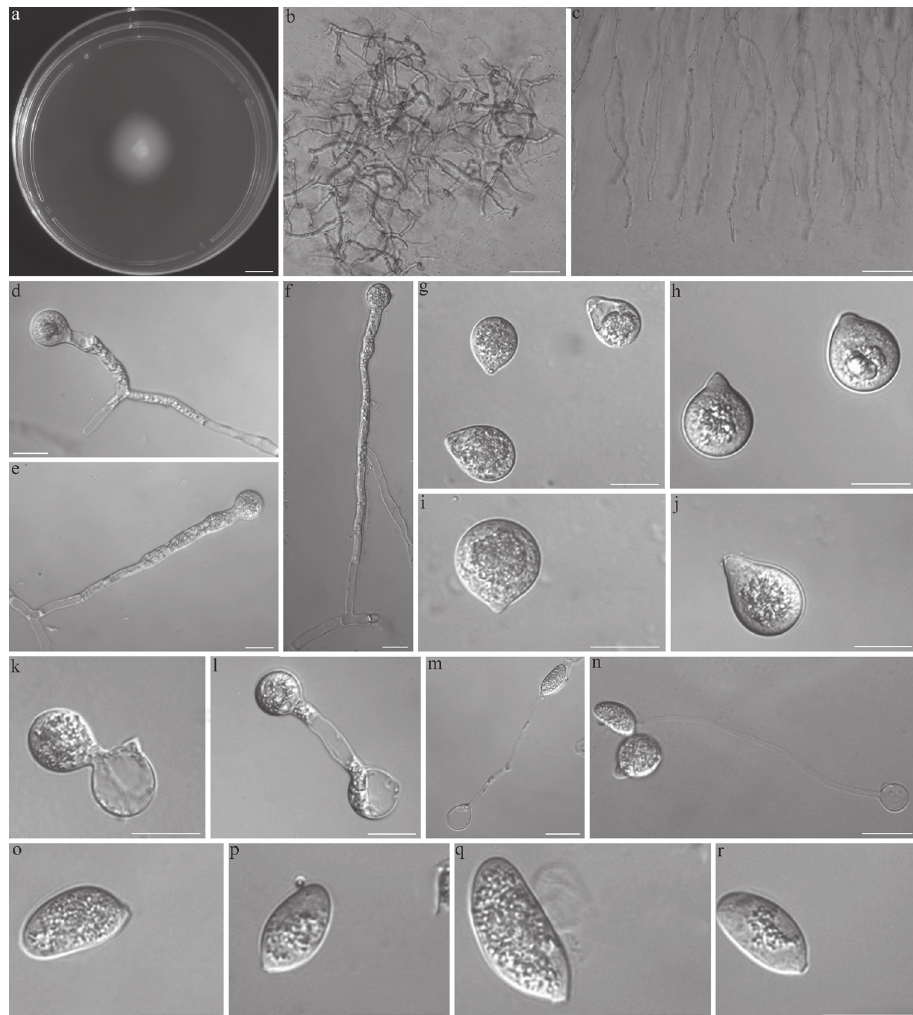
Figure 3. Capillidium jiangsuense a colony on PDA after 3 d at 21 °C b Mycelia c Mycelia unbranched at the edge of the colony d, e, f primary conidiophores arising from mycelia segments g, h, i, j primary conidia k, i secondary conidia arising from primary conidia m, n primary conidia bearing a single capil- liconidium o, p, q, r Capilliconidia. Scale bars: 10 mm ( a ); 100 μm ( b, c ); 20 μm ( d–r